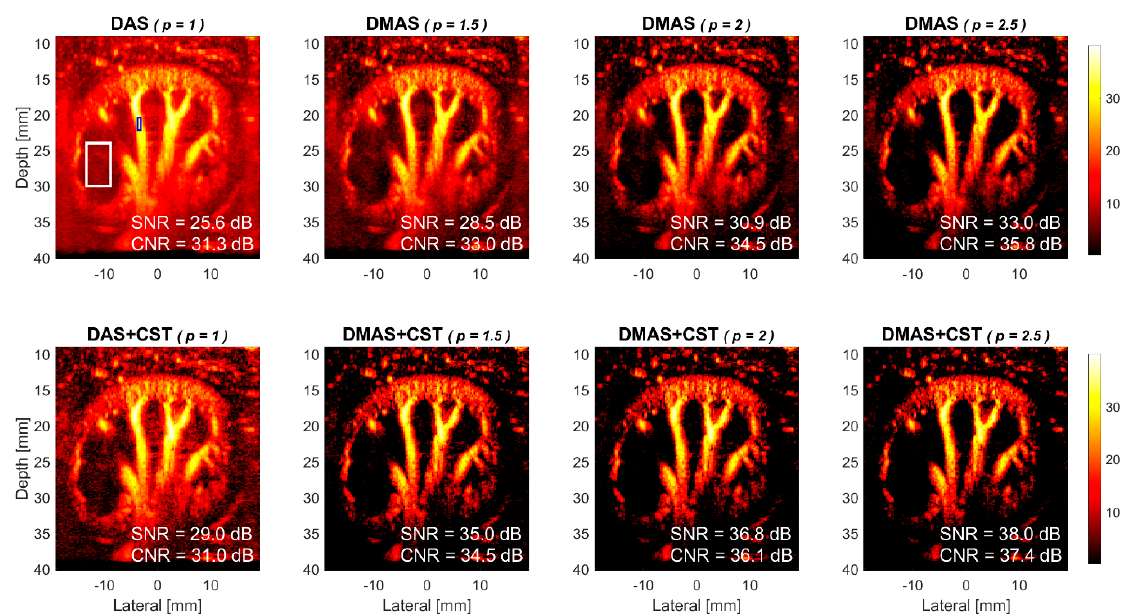
Figure 9. Experimental power Doppler images of rabbit’s kidney for DAS beamforming, DMAS beamforming with the p value of 1.5, 2.0, and 2.5, respectively from left to right. Six PW transmit angles are used (i.e., [ − 5° − 3° − 1° +1° +3° +5°]). Upper panels: without the CST technique. Lower panels: with the CST technique.